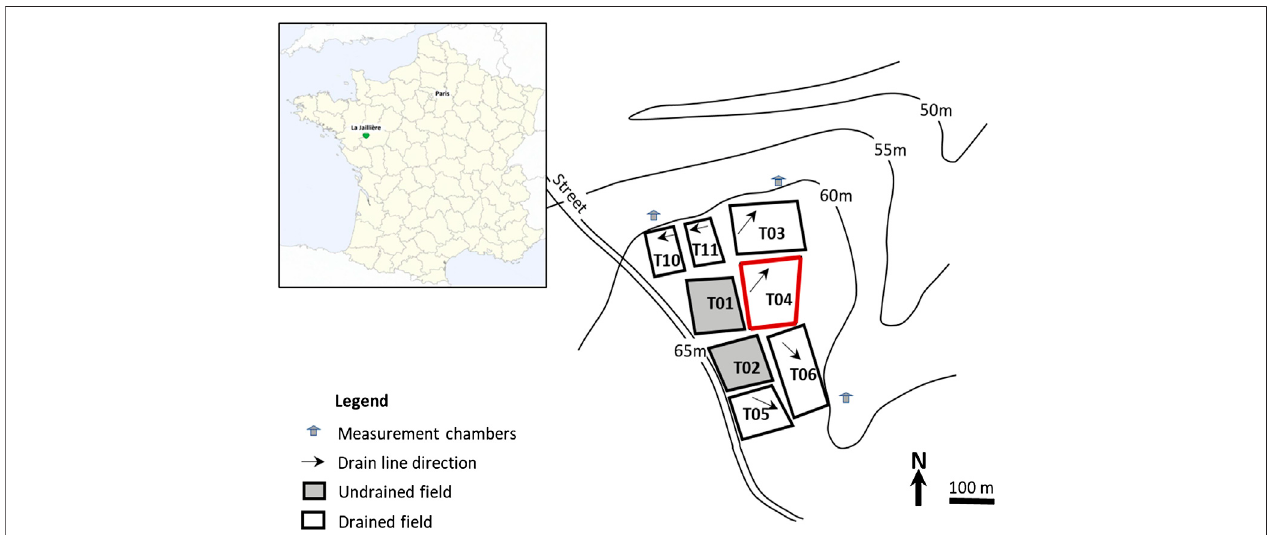
FIGURE 1 | Experimental study site of La Jaillière. Adapted from Henine et al. (2022).